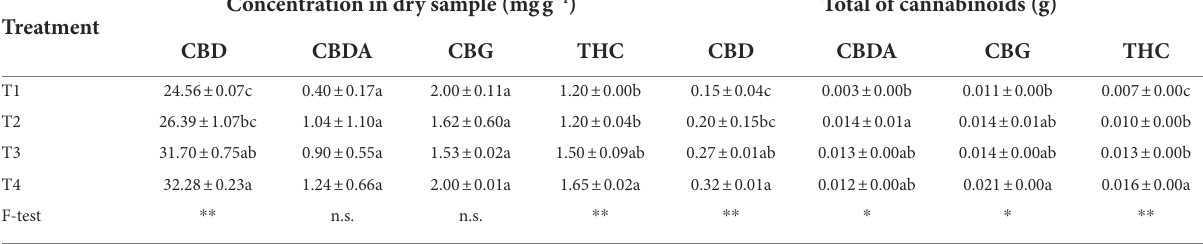
Numbers with different letters in each column indicate significant differences according to the LSD test. Each value in the graph represents the mean ± SD; ( n = 6). T1: control without microbial inoculum, T2: Synthetic fertilizer, T3: Rhizophagus prolifer PC2-2 and T4: R. aggregatus BM-3 g3. * indicates significant difference at p ≤ 0.05; ** indicates significant difference at p ≤